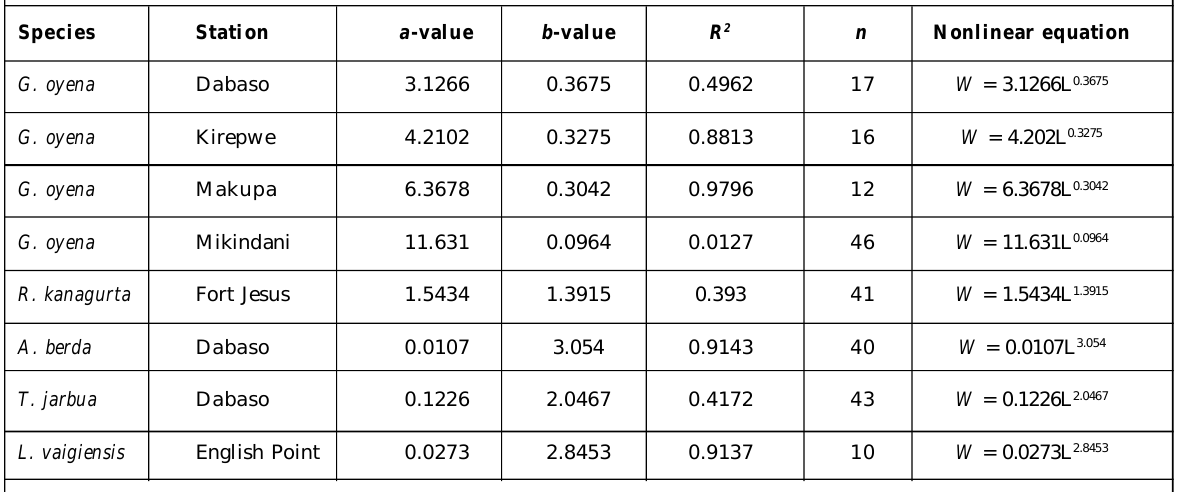
Table 4: Length-weight Von Bertalanffy growth curve parameters for the different fish species Species